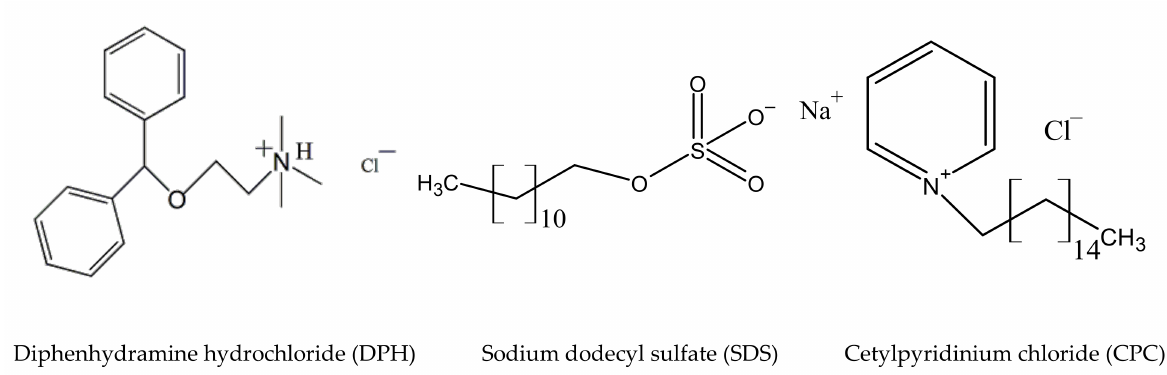
Figure 1. Structure of